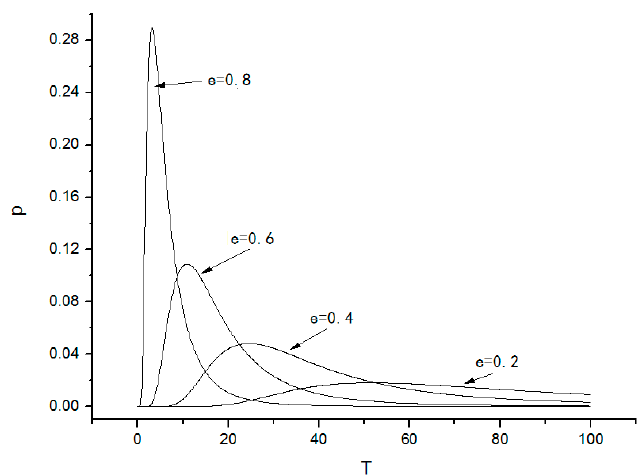
Figure 9. Probability density of the first-passage time.